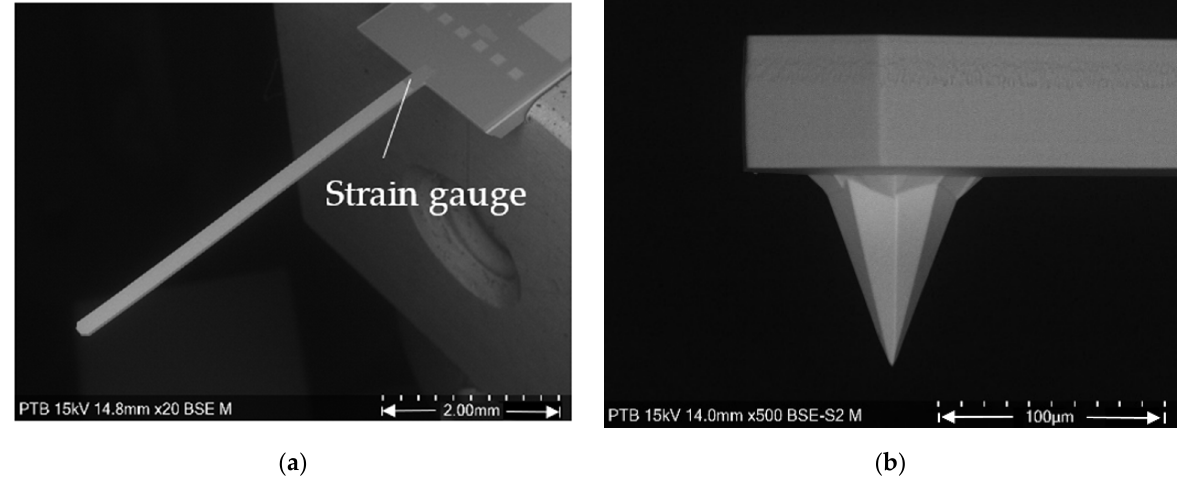
Figure 1. The 5 mm long piezoresistive microprobe. ( a ) Top view; ( b ) side view of tip.